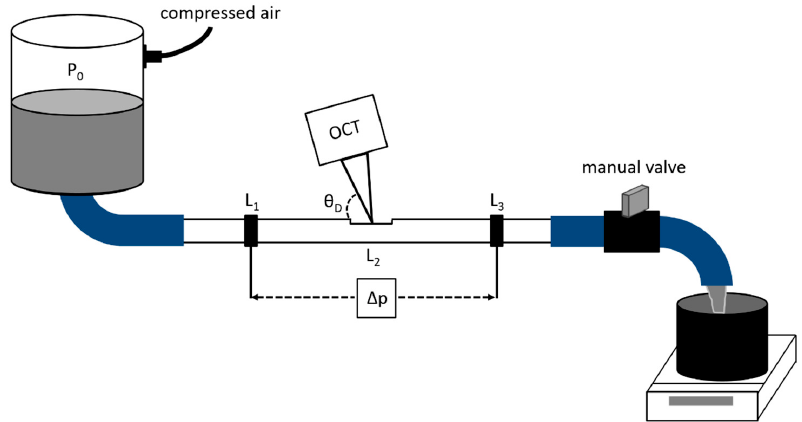
Figure 2. A schematic of the experimental setup. The optical coherence tomography (OCT) measurement is performed for a fully developed laminar flow of the MFC suspension in a straight glass tube with a diameter of D = 8.6 mm. The pressure measurement taps are located at L 1 = 52 D and L 3 = 150 D from the pipe inlet. The OCT is located at L 2 = 110 D from the pipe inlet. A computer- controlled scale is used for the mass flow rate measurements.